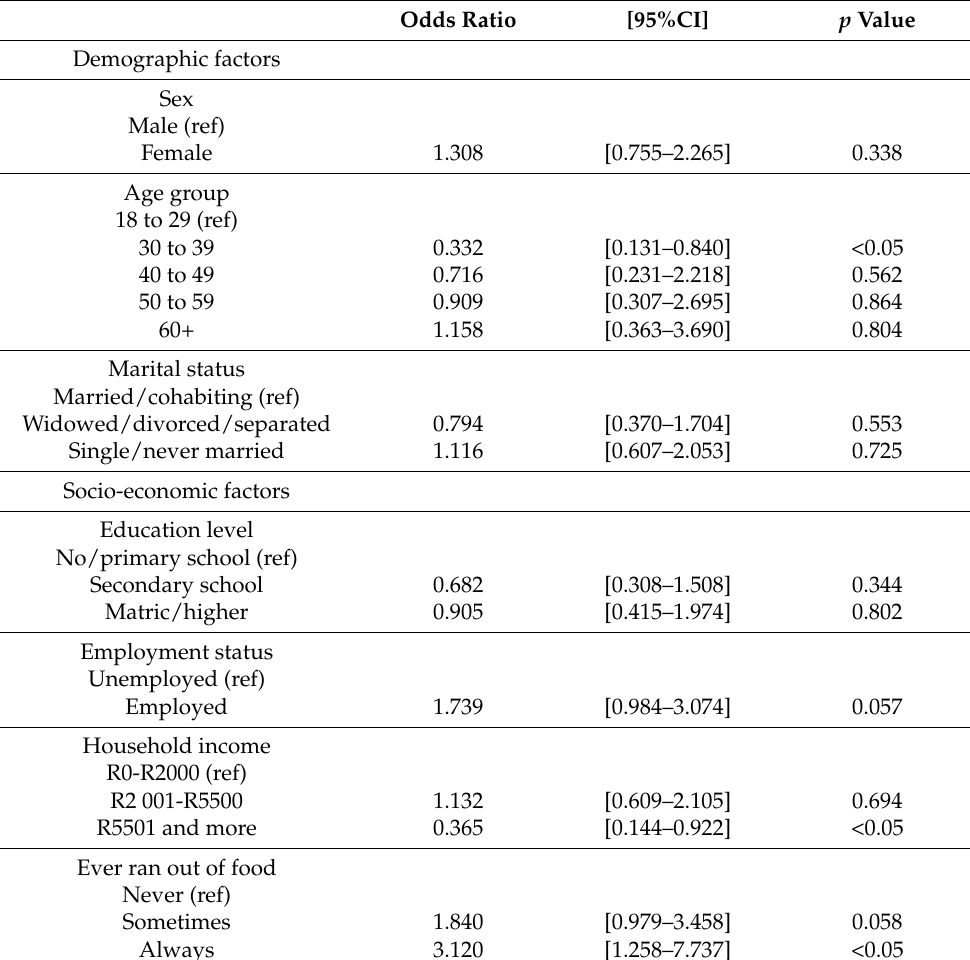
Table 3. Multivariate logistic regression model showing factors associated with deteriorated SPH status among informal settlement dwellers. Odds Ratio [95%CI] p